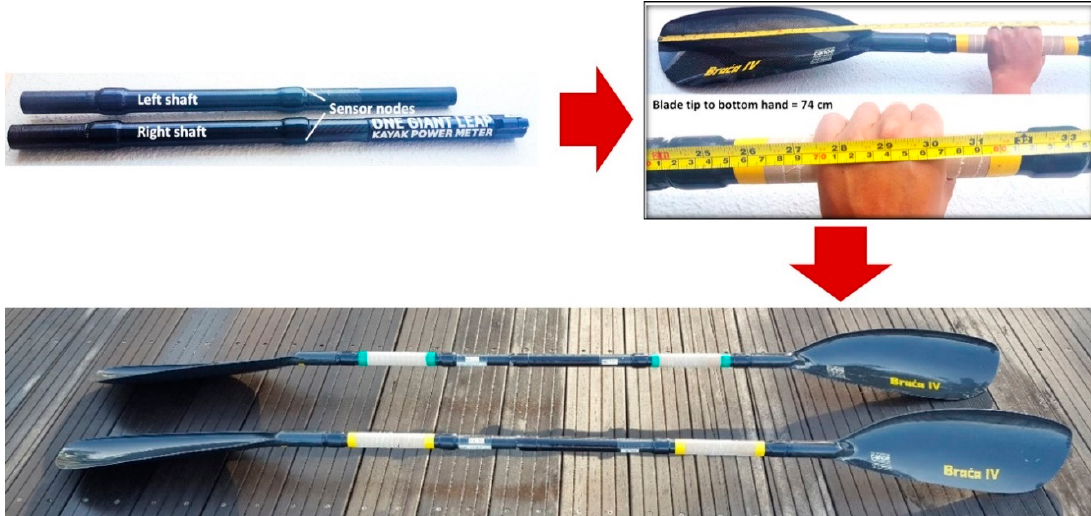
Figure 1. The Kayak Power Meter was designed as an adjustable split-shaft system, with the right shaft being the master control to allow up to 5 cm of paddle length adjustment and preferred blade feather angles. When assembled with paddle blades, the overall mass was 1.010 kg, approximately 12% heavier than a regular paddle of 0.901 kg.